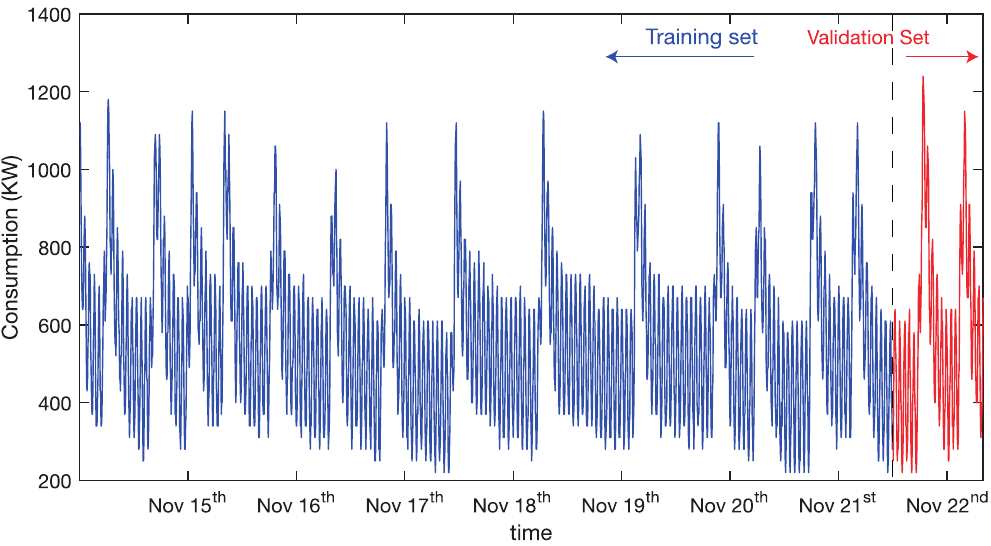
Figure 3. Electricity demand for the hot-dip galvanizing. The ticks represent the beginning of each day. The blue dataset designates the data used for training, whereas the red one represents the data used for testing and validation.